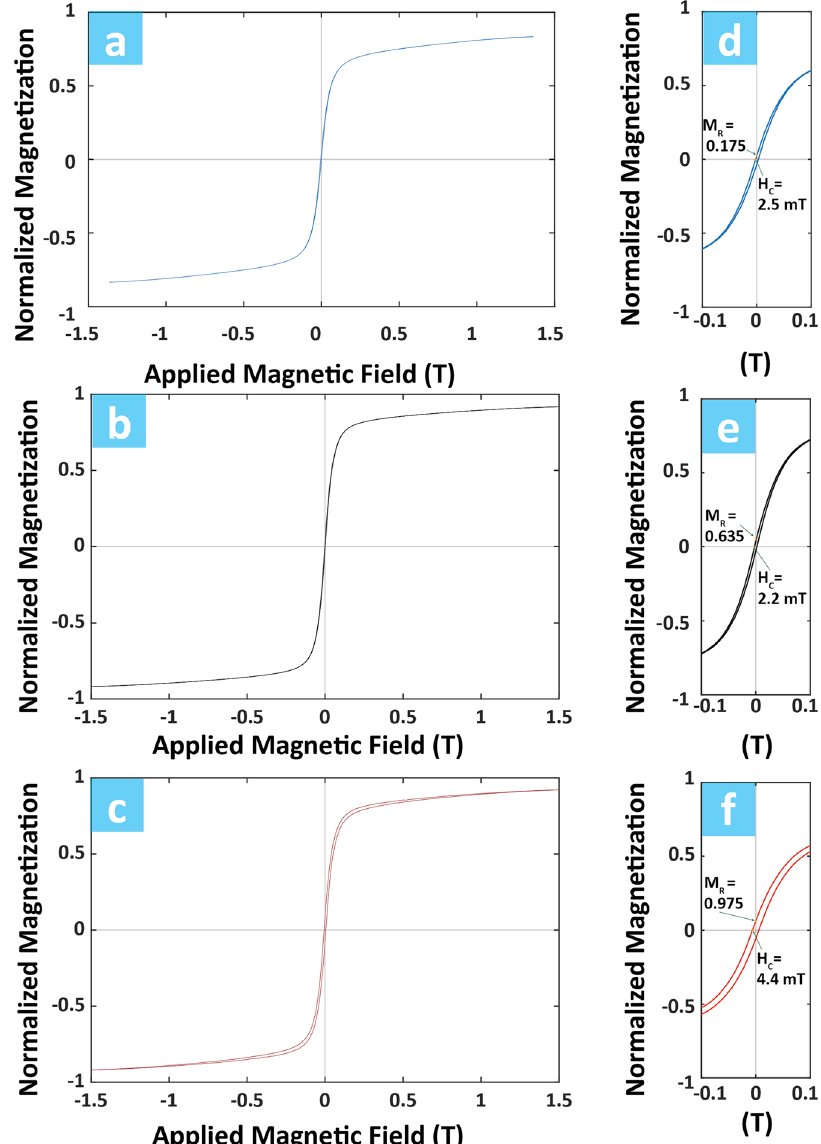
Fig. 3 Magnetic hysteresis. Magnetic hysteresis results for a sea fl oor white pumice b Havre white raft pumice and c pink raft pumice with d – f close ups of the origin of the magnetic hysteresis results highlighting subtle differences in magnetic remanence (M R ) and coercivity (H C ) between the different pumice types. A combination of magnetic parameters (Supplementary Table S3) and frequency dependence of magnetic susceptibility ( χ fd ) are utilized to determine that the white and pink raft pumice hysteresis loops represent a mixture of superparamagnetic (SP) < 10 nm and MD magnetite grains, and that sea fl oor white pumice contains purely MD magnetite. In addition, c , f Havre pink raft pumice displays a classic wasp-waisted hysteresis signature closing past 0.6T suggesting that both magnetite and hematite are present 51 . Duplicates for white and pink raft pumice sample type show similar results as displayed here, while limited material of white sea fl oor pumice allowed for only one